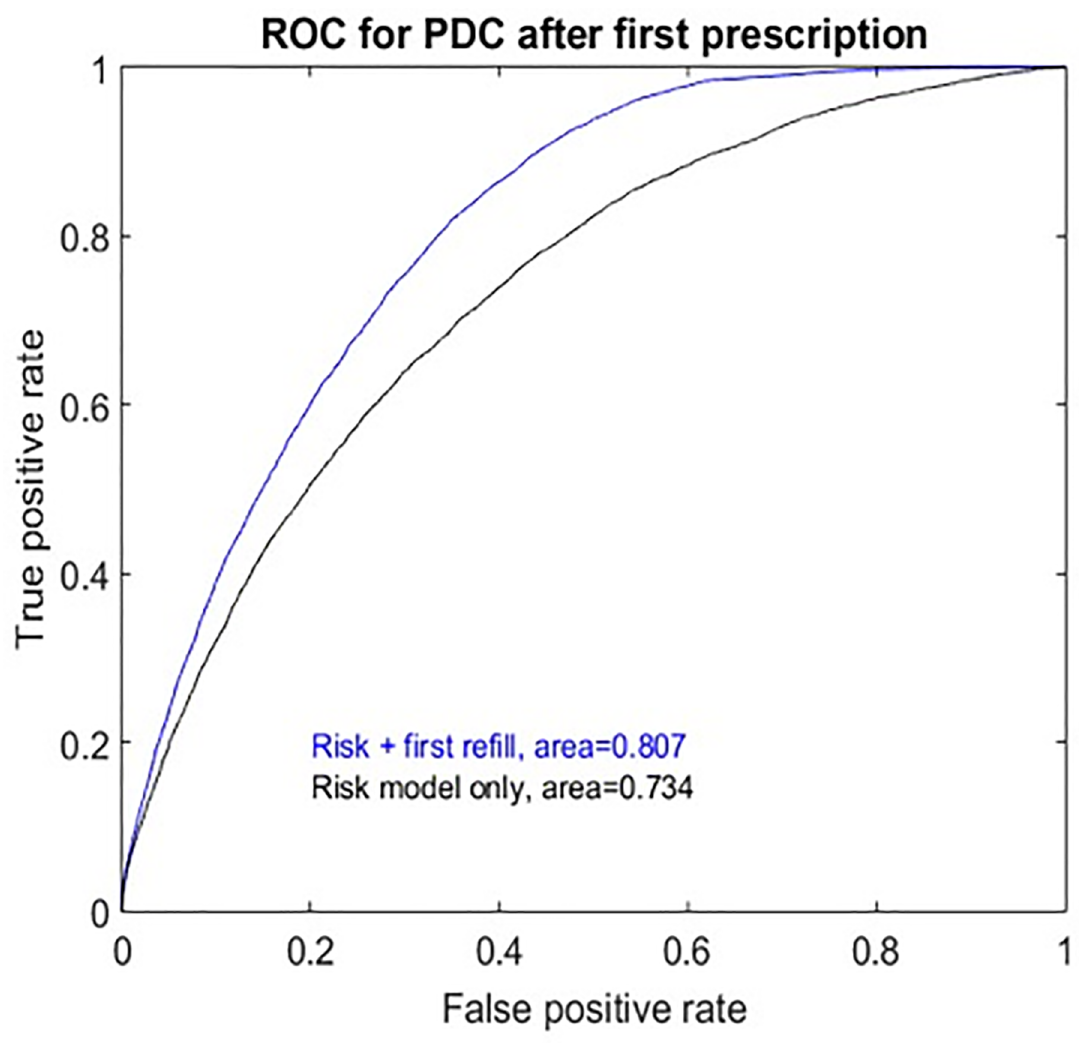
Fig 1. Performanceof statin adherence models. The Receiver operatingcharacteristics (ROC) curves for two models that predict statin adherencedefinedas percent days covered(PDC) greater than 0.8 duringthe follow-upperiod. The results of the risk only model uses randomforest modeling and considersbaselinedemographics, statin prescription characteristics, diseaserisk predictions, and the ‘factors” resultingfrom dimensionreductionto predict statin adherence. The “risk + first refill” model uses the same predictors as the risk only model but also considerswhetheror not the first statin prescription was filled and predicts statin adherence for the remainingtime periodafter the first fill. The area representsthe area under the ROC